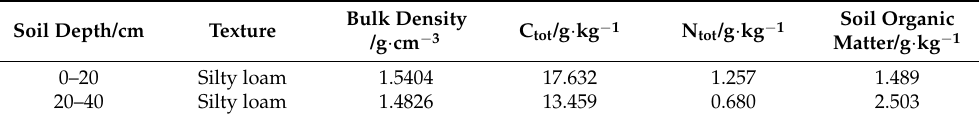
Table 1. Properties of tested soil. Soil